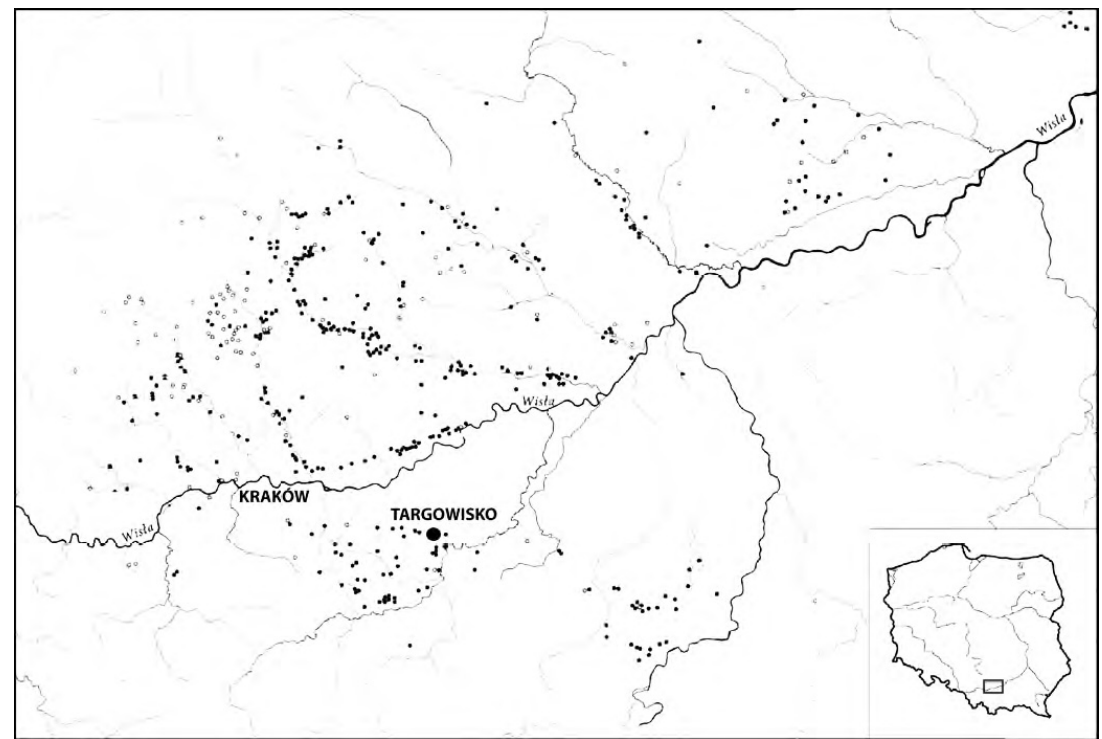
Figure 1: Distribution of the LBK sites in upper Vistula basin (after Czerniak 2013, fig. 1). The buildings recorded at the sites represent multiple phases. Based on a comparative analysis of the stylistic traits of the ceramic assemblage the settlements have been inhabited during the early Neolithic period, particularly from the classic Music Note phase to the late Želiezovce phase and can be dated broadly to 5300–4900 cal BC. Considering the broader context of LBK we can synchronize the periodization for Małopolska region (which is based on the pottery ornamentation styles) with the southwestern Slovakia LBK chronology established by J. Pavúk (Kadrow 1990: 9–76; Pavúk 1969; see also Czekaj-Zastawny, Kadrow, Zastawny 2009: